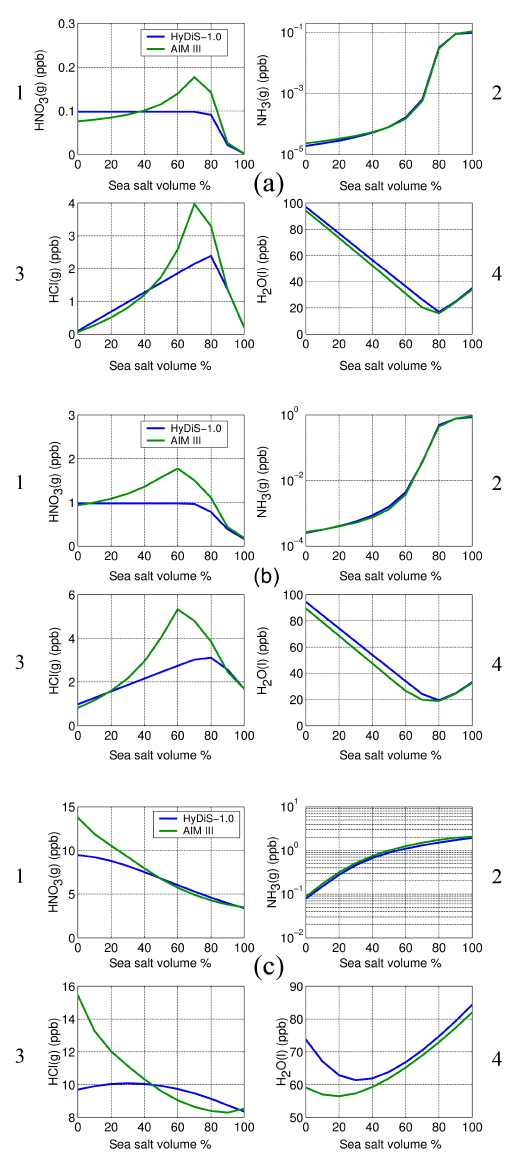
Figure 5. Box-modelling evaluation of HyDiS-1.0 against AIM III with initial mixing ratios of HNO 3 (g) and NH 3 (g) of 0.1 (a) , 1 (b) and 10 (c) ppb. The sea salt volume fraction is varied according to the values given in Table 1. The equilibrium vapour pressures are calculated with HyDiS-1.0 and AIM III for the equilibrium par- ticle composition assessed with the former. The vapour pressures are given as mixing ratio equivalents for HNO 3 (1), NH 3 (2), and HCl (3) along with the total particle water mass (4). Note that par- ticle composition is not size-dependent and that due to equilibrium composition discrepancies the AIM III HCl vapour pressure may be larger than its total